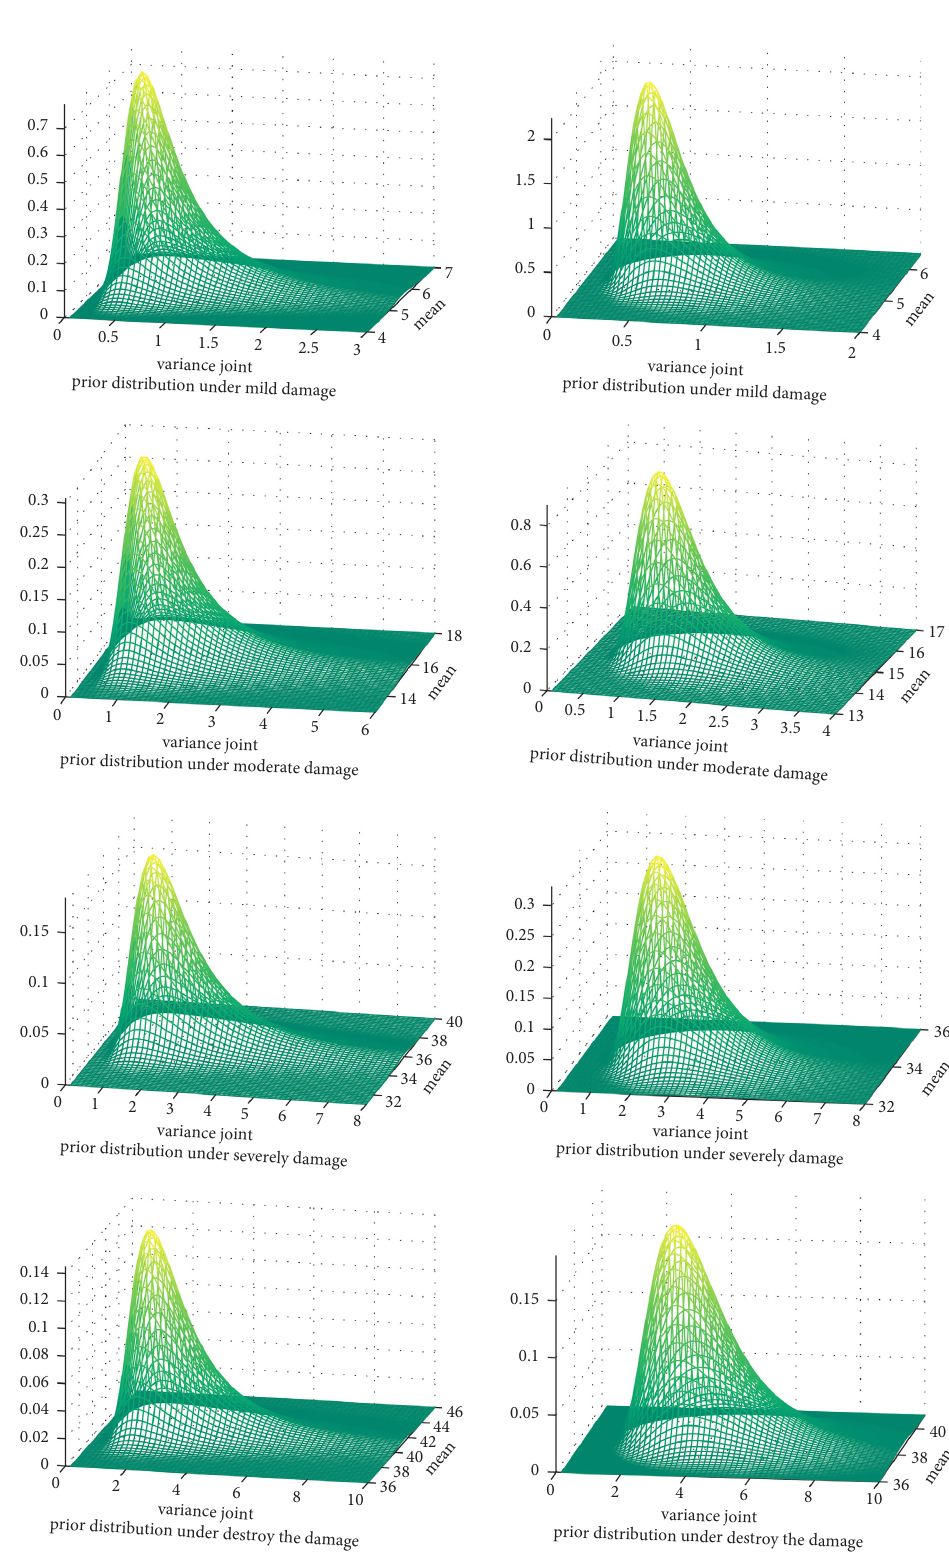
Figure 2: Joint prior distribution and joint posterior distribution of